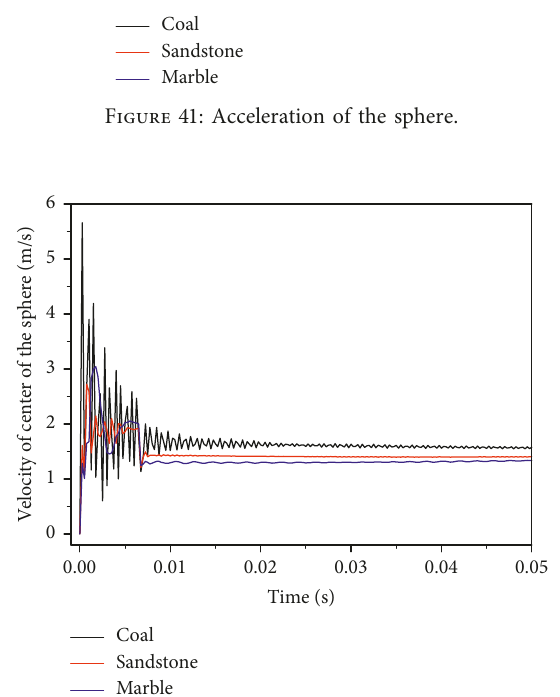
Figure 42: Velocity of the sphere.